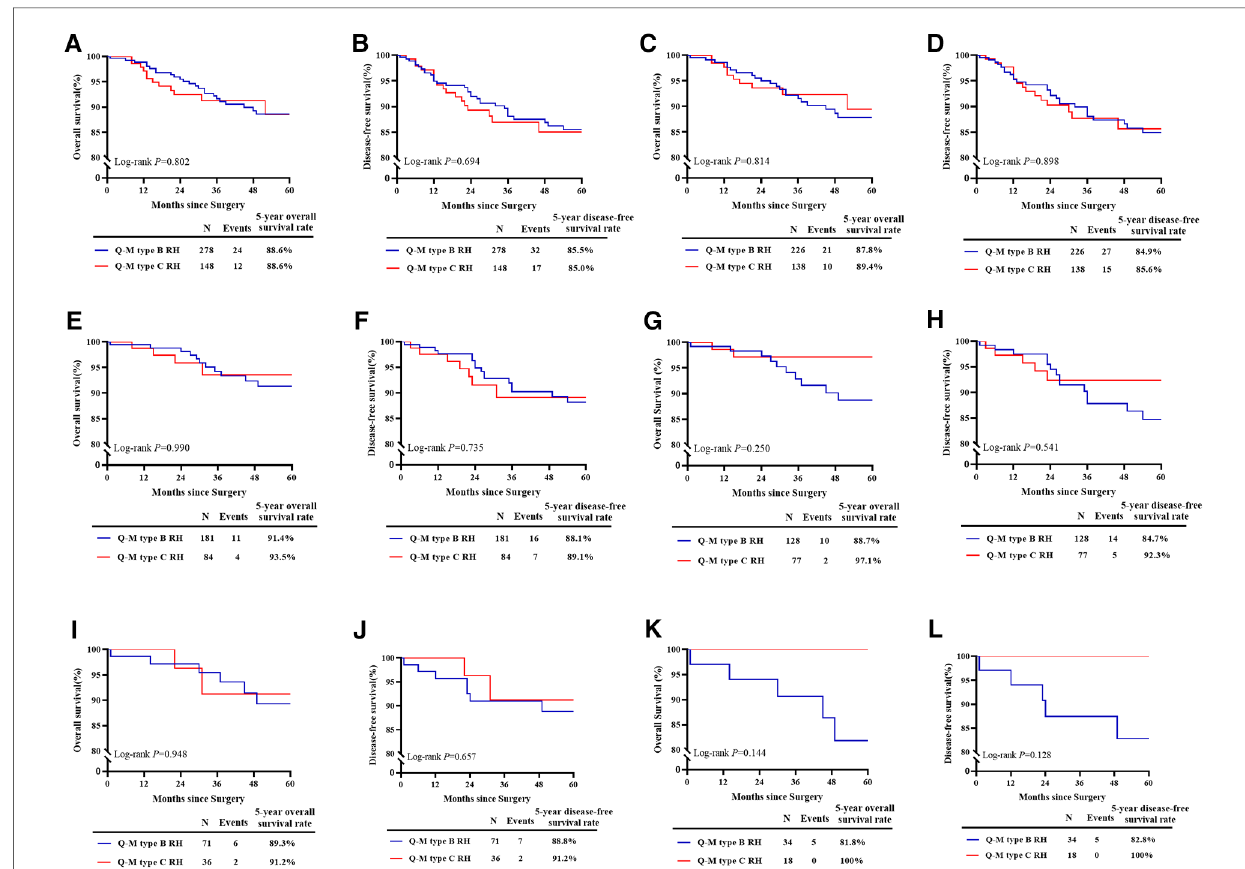
FIGURE 2 Survival estimates of patients with FIGO stage IA2-IB2 and IIA1 cervical cancer. ( A ): The 5-year OS of all patients in the real world ( n =426). ( B ): The 5-year DFS of all patients in the real world ( n =426). ( C ): The 5-year OS after matching ( n =364). ( D ): The 5-year DFS after matching ( n =364). ( E ): The 5-year OS of patients with speci fi c histological subtypes ( n =265). ( F ): The 5-year DFS of patients with speci fi c histological subtypes ( n =265). ( G ): The 5-year OS of patients with speci fi c histological subtypes after matching ( n =205). ( H ): The 5-year DFS of patients with speci fi c histological subtypes after matching ( n =205). ( I ): The 5-year OS of patients with deep stromal invasion ( n =107). ( J ): The 5-year DFS of patients with deep stromal invasion ( n =107). ( K ): The 5-year OS of patients with deep stromal invasion after matching ( n =52). ( L ): The 5-year DFS of patients with deep stromal invasion after matching ( n